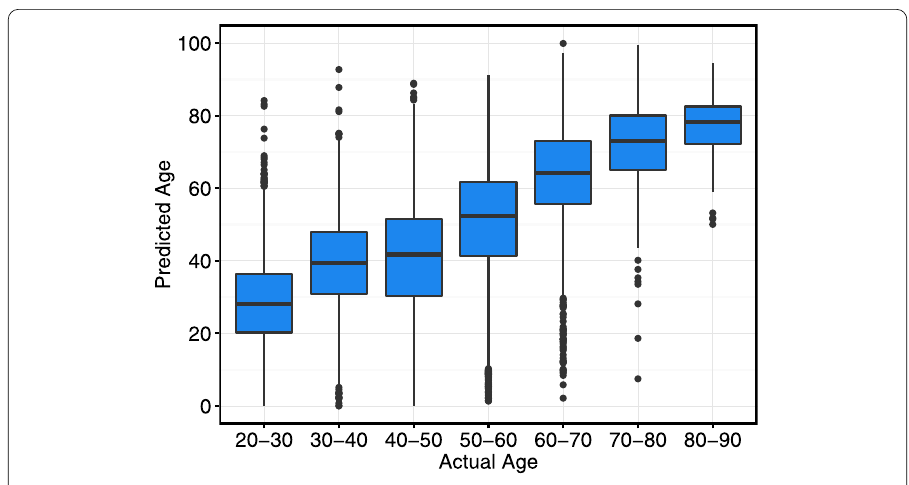
Figure 9 Age prediction in the EU data using elastic-net achieves R 2 = 0.35, when data points are weighted according to their inverse frequency . An elastic net model with uniform weights achieves a higher R 2 = 0.47 (not shown). Actual ages are grouped into 10 year